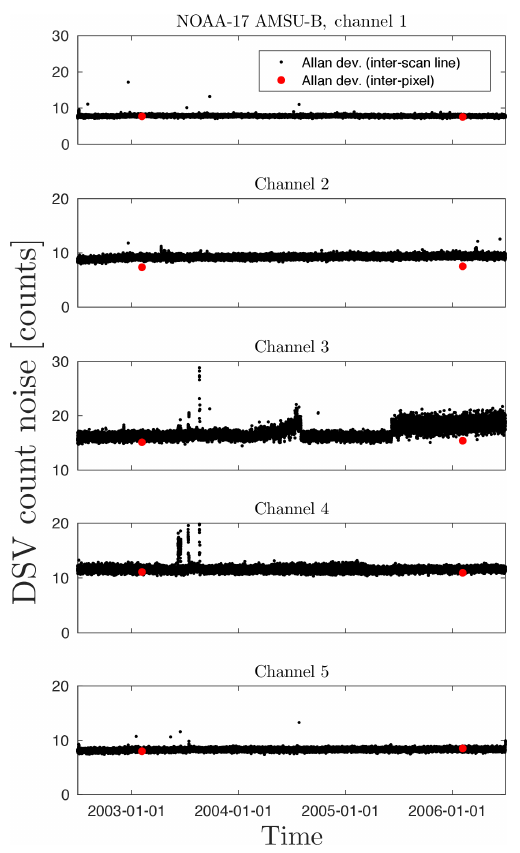
Figure 5. The DSV count noise per channel for the years 2003 to 2006 for AMSU-B on NOAA-17. The red dots indicate the noise in DSV counts calculated with the inter-pixel method. For comparison with the inter-scan-line method, we applied this method exemplarily only for these two orbits, 500 of the year 2003 and 500 of the year 2006, for which we investigated the spectrum as well (see Fig.